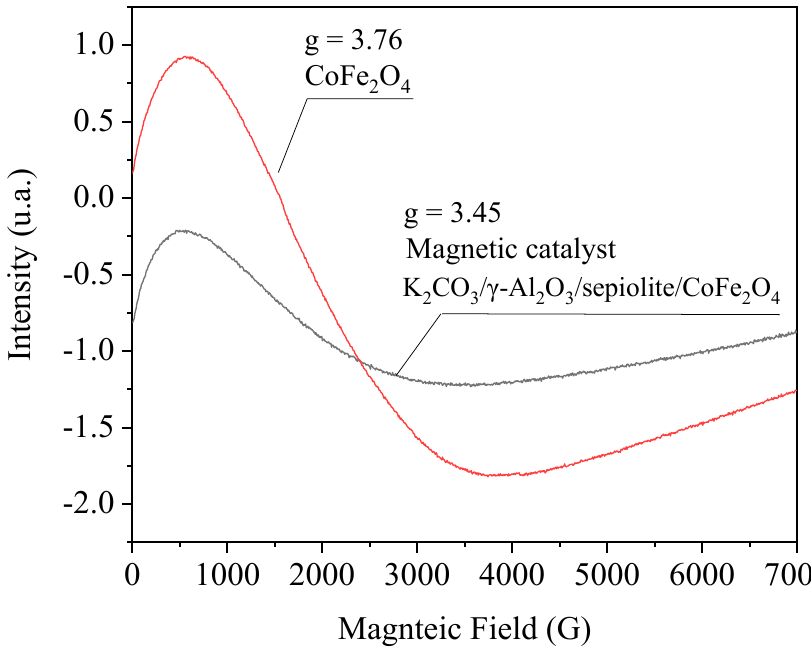
Figure 9. EPR spectra recorded at 298 K for CoFe 2 O 4 and K 2 CO 3 / γ Al 2 O 3 /sepiolite/CoFe 2 O 4.